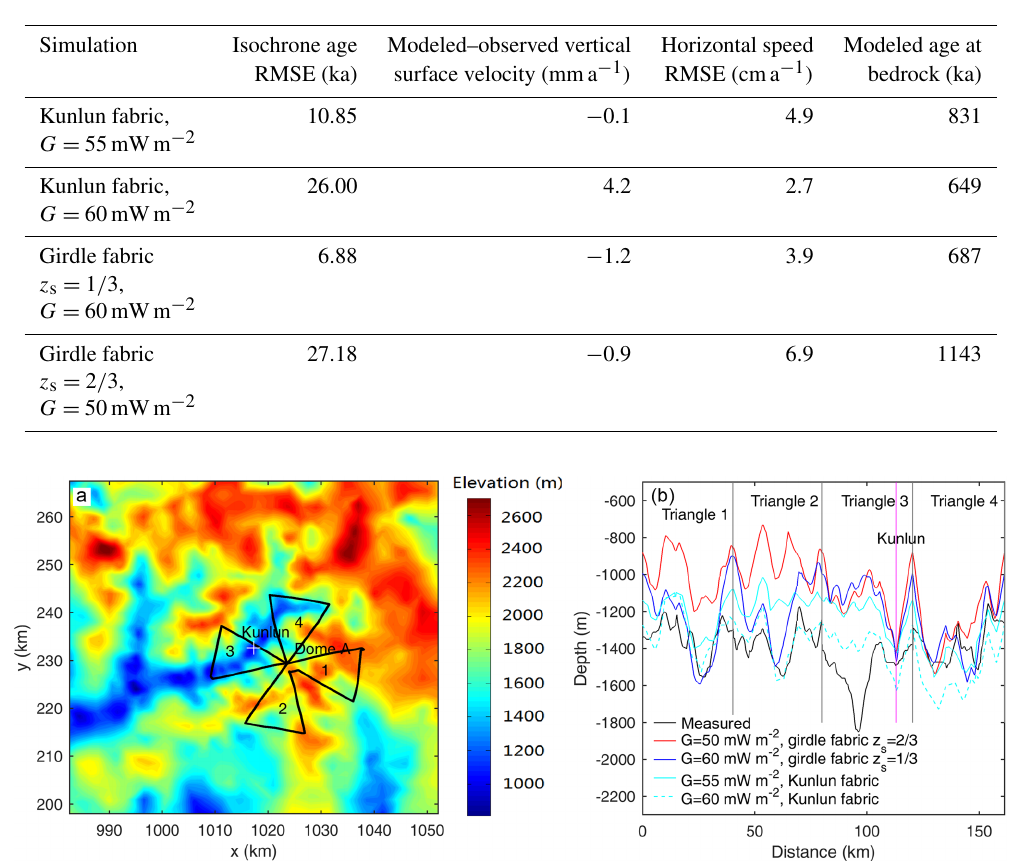
Figure 4. (a) Measurement tracks (black curve) consisting of four triangles, for the depth of the 153.3ka isochrone layer; the common point of the four triangles is Dome A; the white cross is Kunlun station; the background is bedrock elevation in a 70 × 70km 2 region. (b) The measured (black) and modeled (colored) depths of the 153.3ka isochrone using the simulations shown in Fig. 3. The distance coordinate in (b) starts from Dome A and follows the tracks of triangles 1–4, with Dome A passes marked by vertical black lines, and Kunlun station marked as a vertical magenta line in triangle